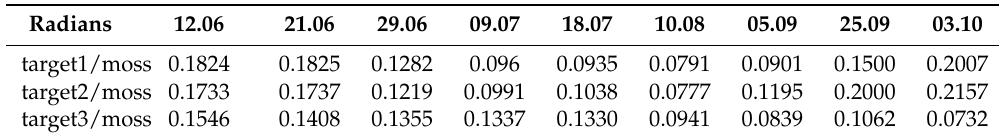
Table 4. The Spectral Angle Mapper (SAM) values between the reference spectrum and target spectra during the growth period.